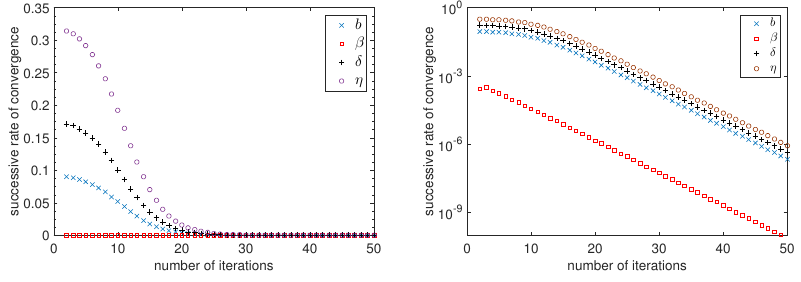
Figure 2. Successive rate of the convergence for the parameters in standard and logarithmic scale. R 1 = 300 ,R 2 = 600, left - for h = 1, right - for h = 0 .